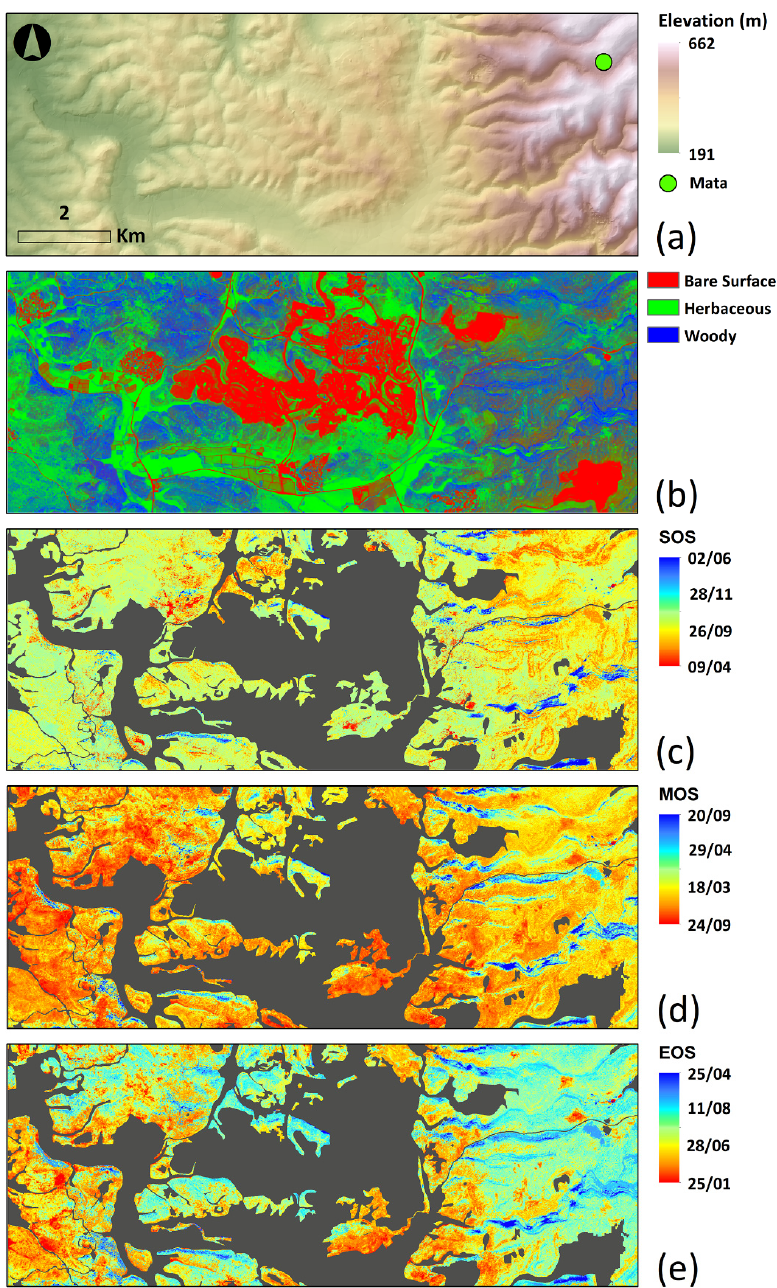
Figure 13. VEN μ S processed study area; ( a ) the location of Mata over the elevation base map. ( b ) bare surface, woody vegetation and herbaceous vegetation components. ( c – e ) a pixel-based analysis of phenological indices—start of season (SOS), maximum of season (MOS), and end of season (EOS), computed by TimeSat 3.3 software, for the time period between October 2018 and September 2019, using 62 cloud-free VEN μ S images. Grey areas represent urban, bare surface and agricultural land uses, which were masked out and not included in our analysis. The percent cover of herbaceous vegetation was negatively correlated with both MOS and EOS (with correlation coefficients of about − 0.5; Table 8). Slope and aspect were more